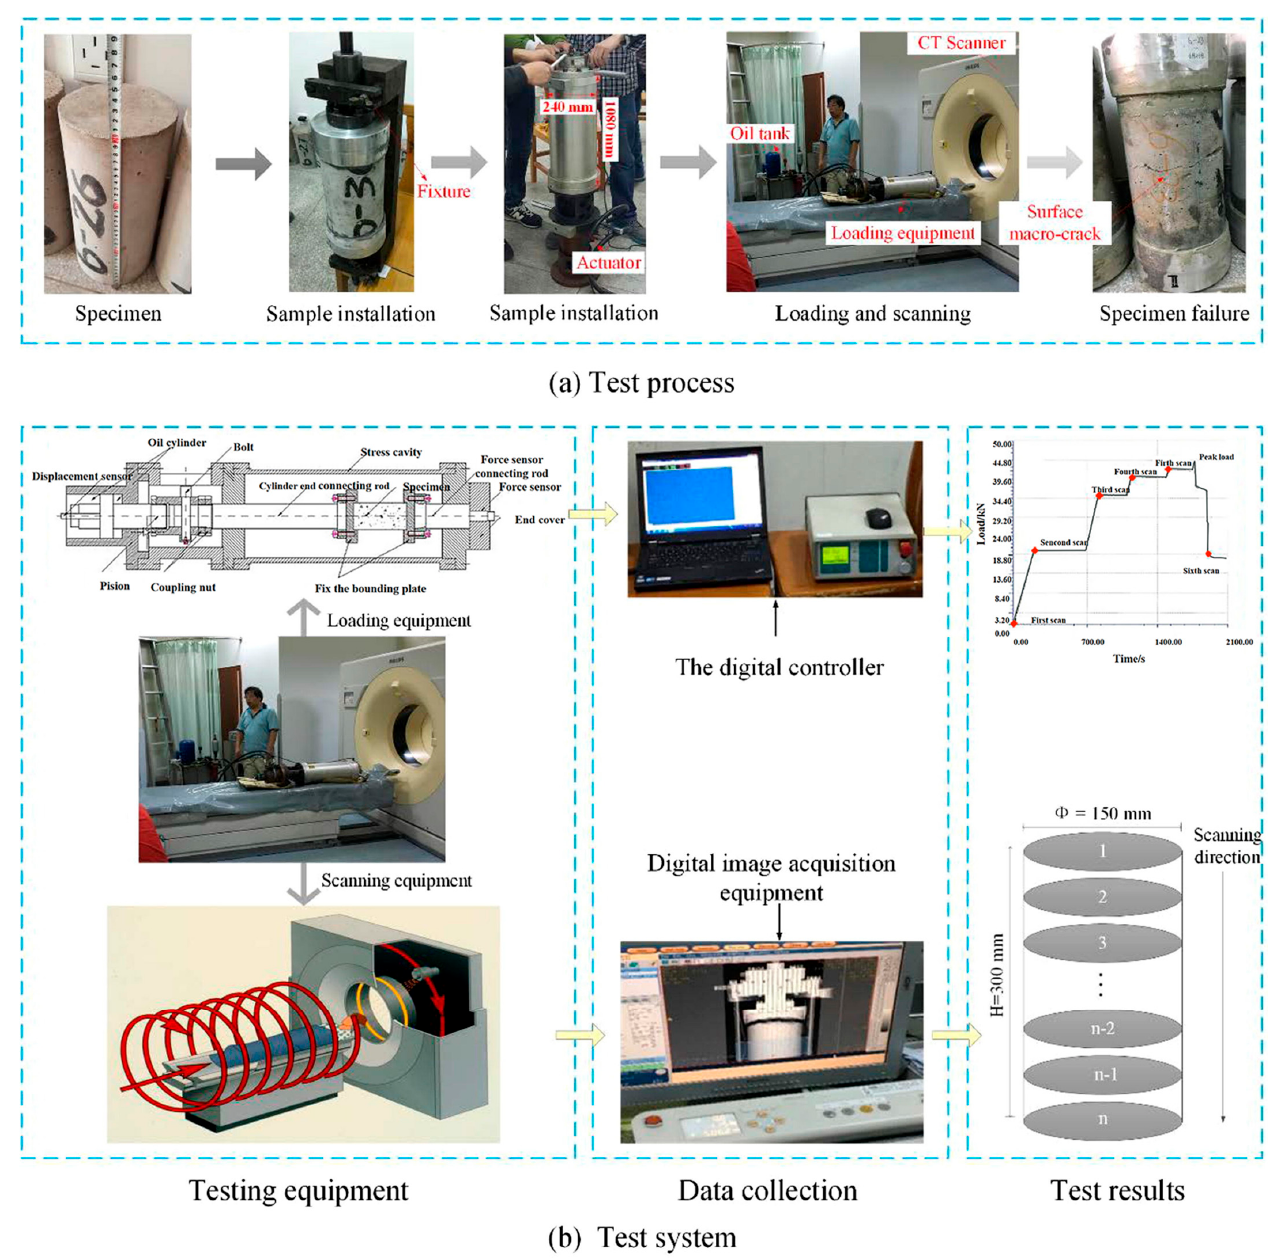
Figure 20. Concrete CT test: ( a ) Test process; ( b ) Test system [184].